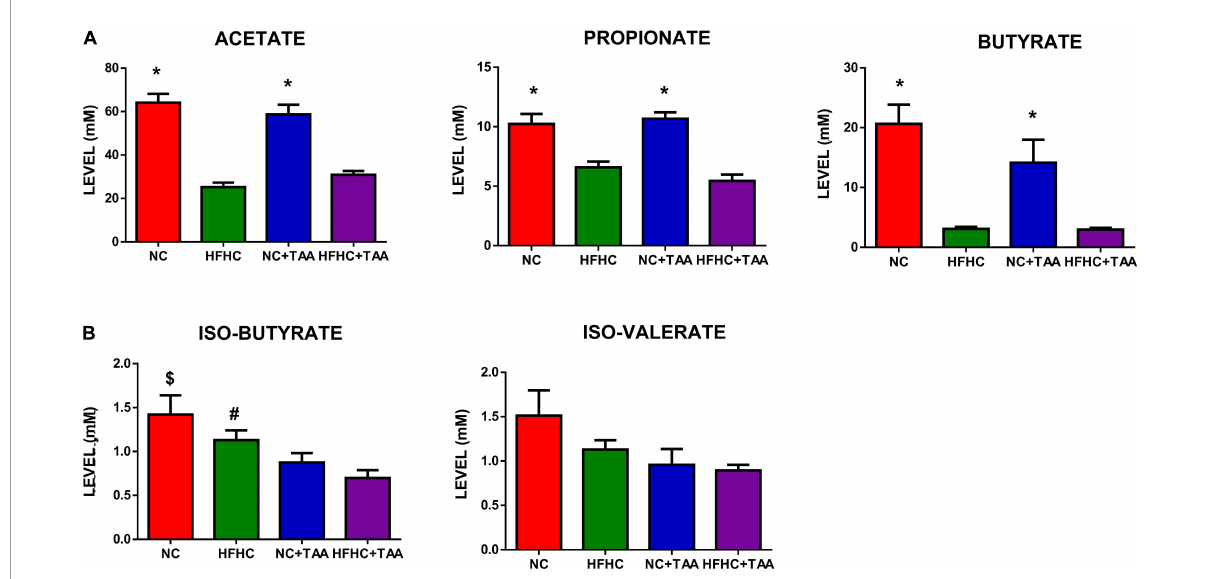
FIGURE9 SCFA and BCFAs levels. Bars charts (mean ± SEM) represent the (A) SCFAs and (B) BCFAs levels (mM) compared through the Kruskal–Wallis test followed by Dunn’s analysis (*comparison with HFHC and HFHC + TAA groups; $ comparison with NC + TAA and HFHC + TAA groups; # comparison with HFHC + TAA group; * #$ p < 0.05).